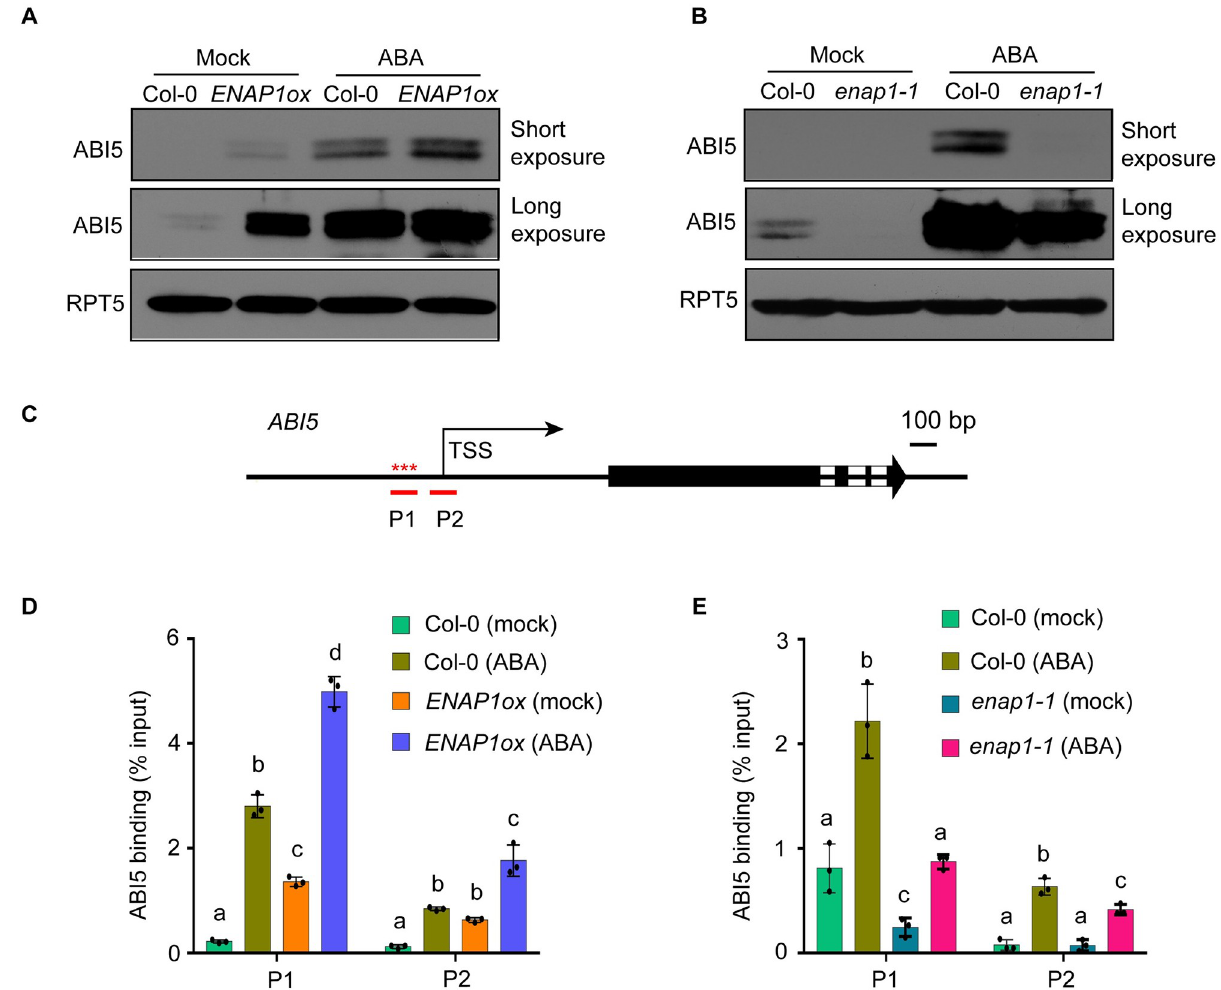
Fig 6. ENAP1 is involved in the positive feedback regulation of ABI5 . ( A ) Western blot to examine ABI5 protein levels in Col-0 and ENAP1ox . Total proteins were extracted from seeds germinated for 24h with the presence of mock or 2 μ M ABA treatment. RPT5 was used as loading control. ( B ) ABI5 protein levels in Col-0 and enap1-1 . Total proteins were extracted from seeds germinated for 24h with the presence of mock or 0.5 μ M ABA treatment. ( C ) Primer locations in the promoter region of ABI5 . Two primers (P1 and P2) were designed along ABI5 promoter for following ChIP-qPCR. Asterisks represent ABI5 binding motifs. ( D ) ChIP-qPCR to show ABI5 protein enrichment on ABI5 gene. ChIP assay was performed in seeds treated as in ( A ). ( E ) ABI5 protein enrichment on ABI5 gene in Col-0 and enap1-1 . Col-0 and enap1-1 seeds treated as in ( B ) were used for the ChIP assay. All quantified data represent means ± s.d. of three replicates. Different letters represent significant differences with P < 0.05 in the one-way ANOVA test.